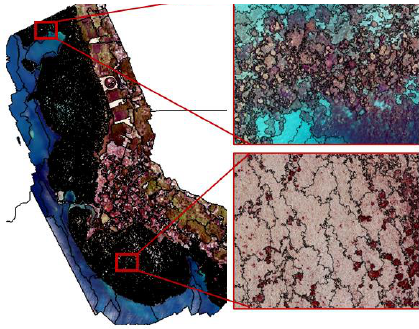
Fig. 2. Level 1 of image classification